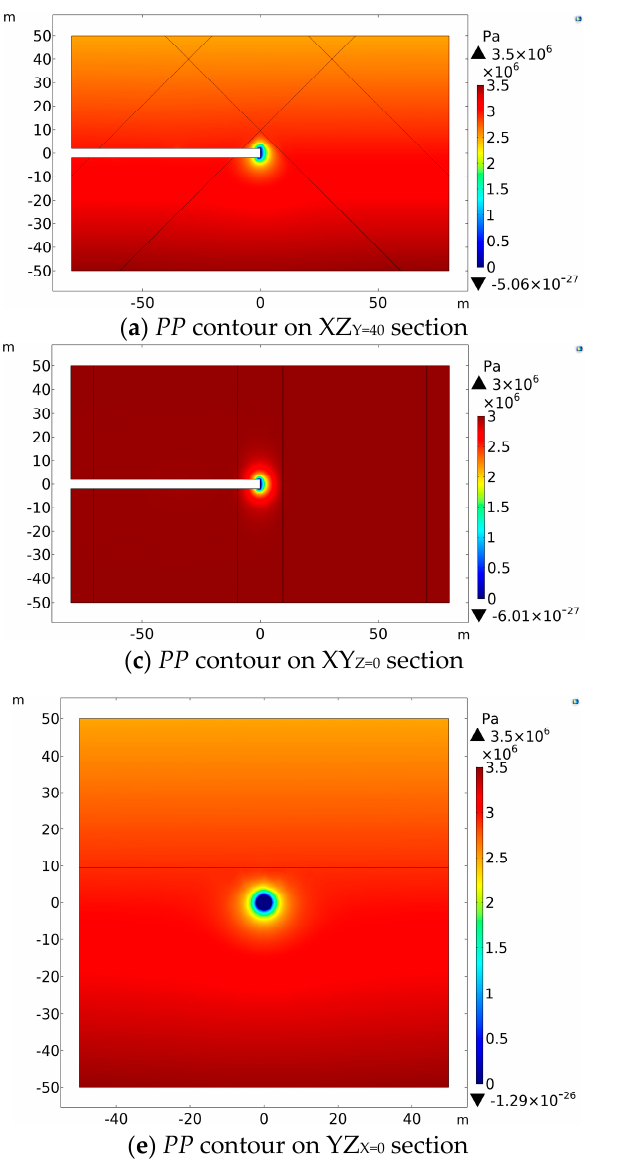
( f ) FV contour and vector diagram on YZ X=0 section Figure 2. Simulation results for the case Y = 40 m. The PP contours in Figure 2a,c,e show that a low-pressure region appears at the excavation face and on the tunnel wall within 1.0 m rearwards and the PP increases outward with the increases in distance. On the cross-section of XZ Y = 0 , PP contours are distributed elliptically symmetrically along the x -axis, and the ellipse’s major axis is parallel to the z -axis. In the vertical downward direction, the PP value gradually increases with the burial depth of the tunnel in a circular or semicircular distribution nearby the tunnel face, as